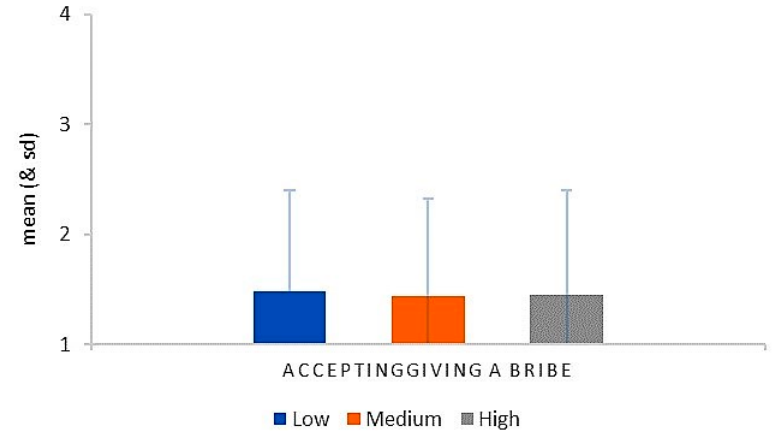
Figure 16. Accepting/giving a bribe by the level of religiosity. (The error bars represent standard deviation).